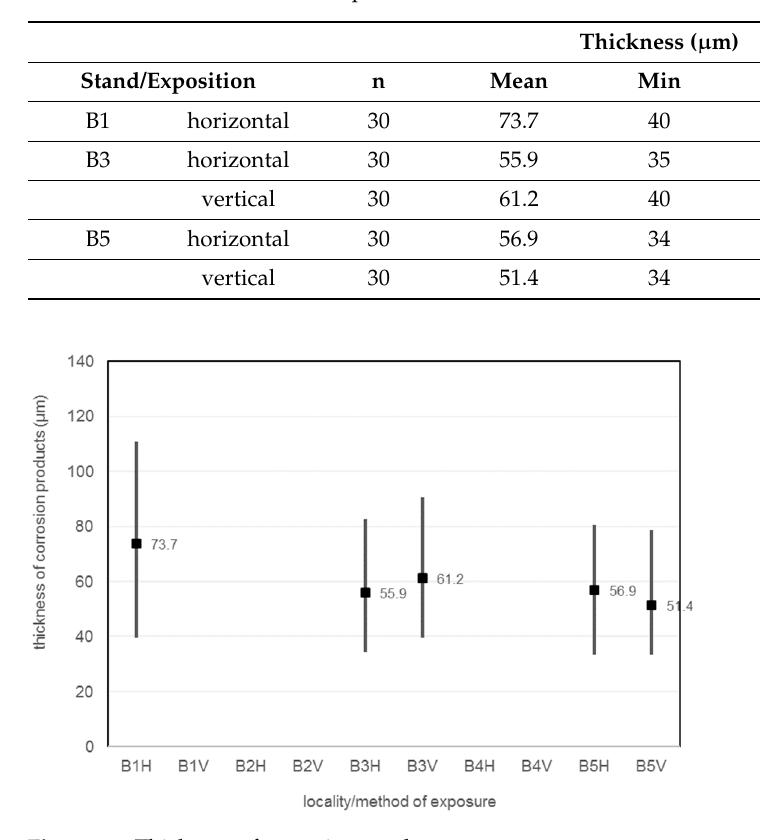
Table 23. Colorimetric parameters of exposed